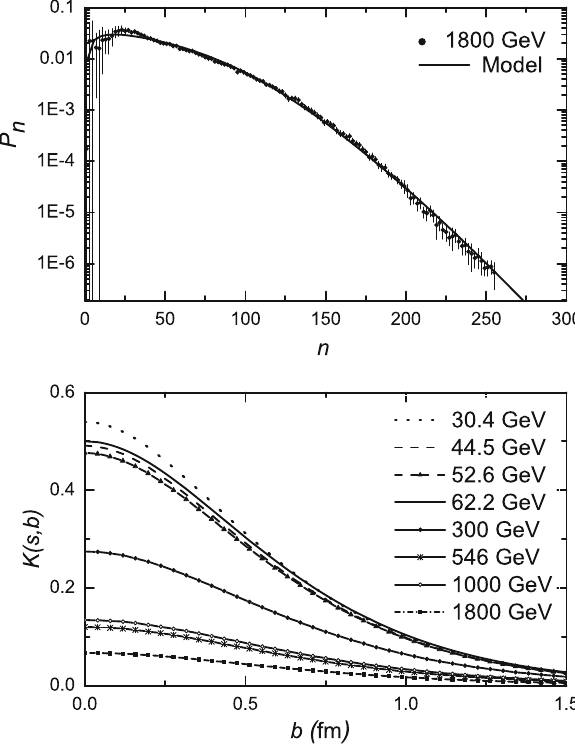
Fig. 6 Same as Fig. 1 but at 546 GeV. Data points from [16]